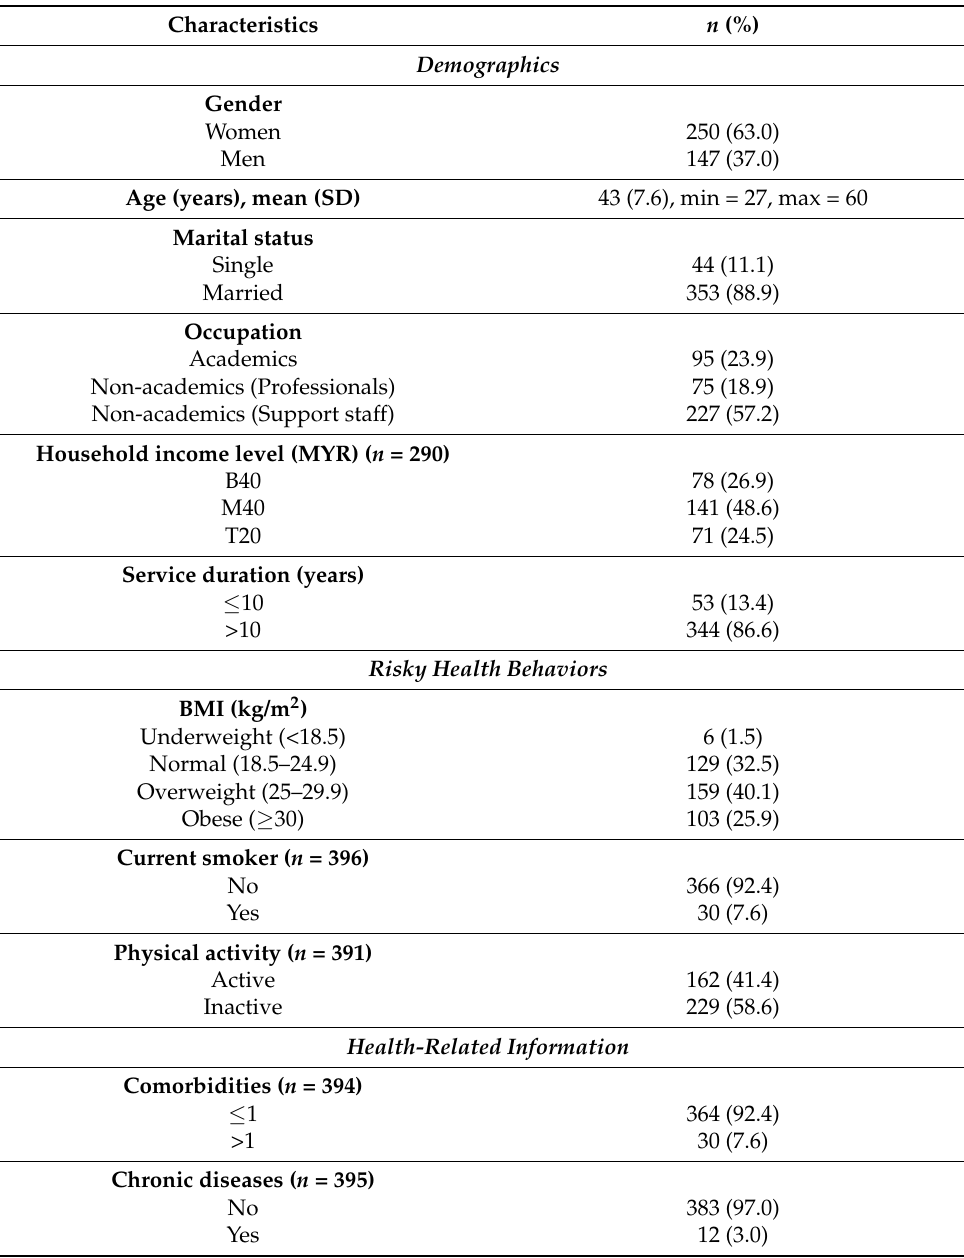
Table 1. Sample characteristics ( n =